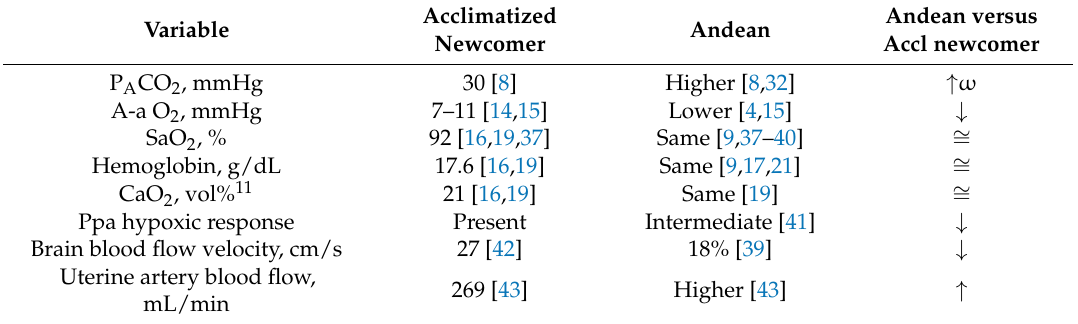
Table 1. Determinants of O 2 transport in long-term highland groups and acclimatized newcomers at ~3600–4300